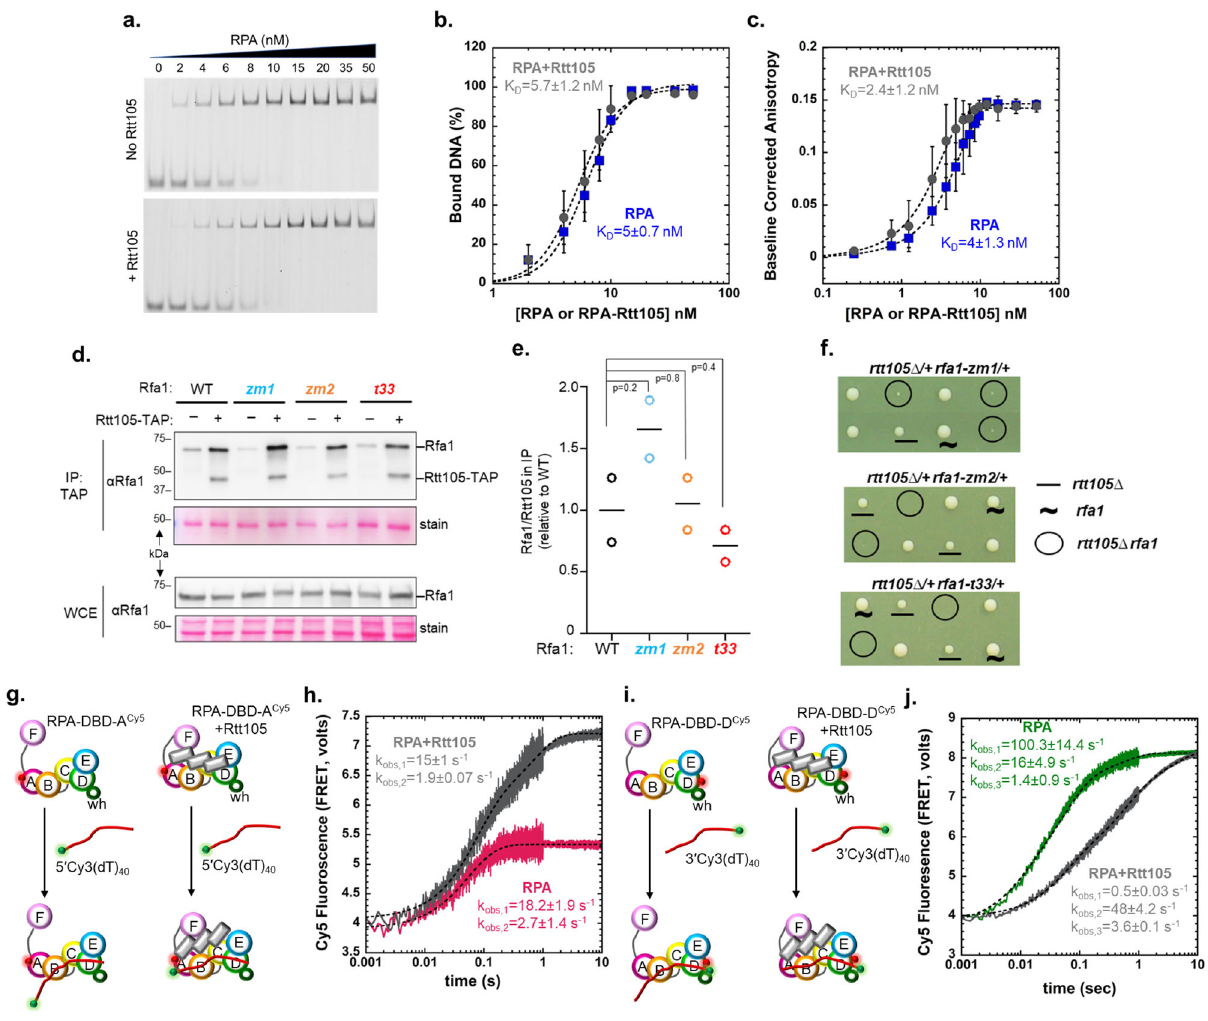
Fig.2|Rtt105altersthecon fi gurationofDBD-AonssDNAandkineticsofDBD- D binding. a EMSA of RPA binding to 5 ′ -Cy5-(dT) 30 ssDNA and b quantitation shows no appreciable difference in DNA binding af fi nity in the absence (K D =5± 0.7nM) or presence of Rtt105 (K D =5.7±1.2nM). c Fluorescence anisotropy mea- surementsofRPAbindingto3 ′ -FAM-(dT) 35